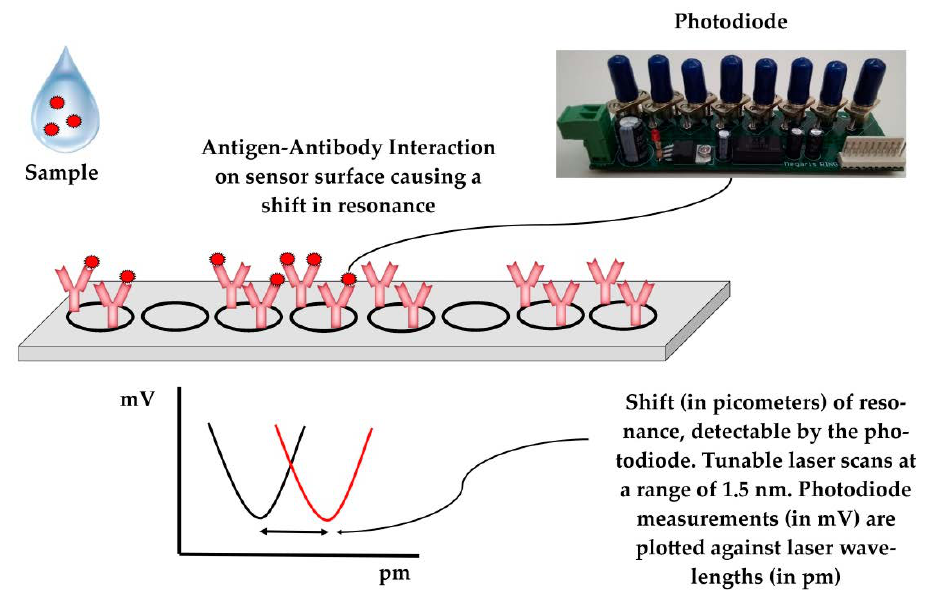
Figure 2. Sensors and the principle of viral detection.